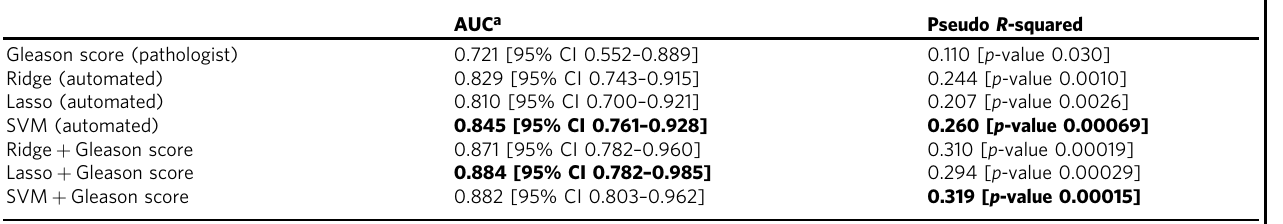
Table 3 Comparison of biochemical recurrence (BCR) within 1